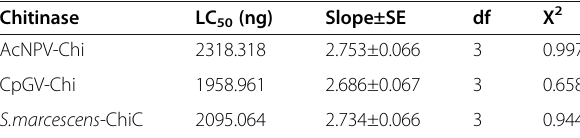
Table 1 LC 50 values of AcNPV-Chi, CpGV-Chi, and Serratia marcescens -ChiC proteins